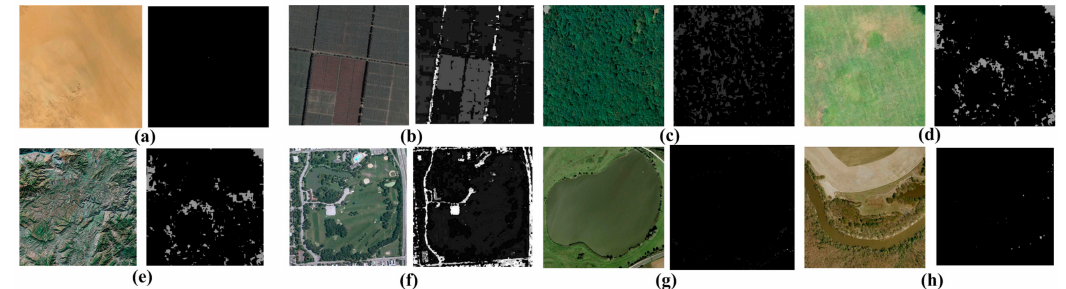
Figure 22. Several examples and their corresponding color boosted saliency maps of different categories misclassified by the color boosted saliency-guided rotation invariant BOVW representation with parameter transfer in the WHU-RS dataset: ( a ) desert, ( b ) farmland, ( c ) forest, ( d ) meadow, ( e ) river, ( f ) park, ( g ) pond, and ( h )